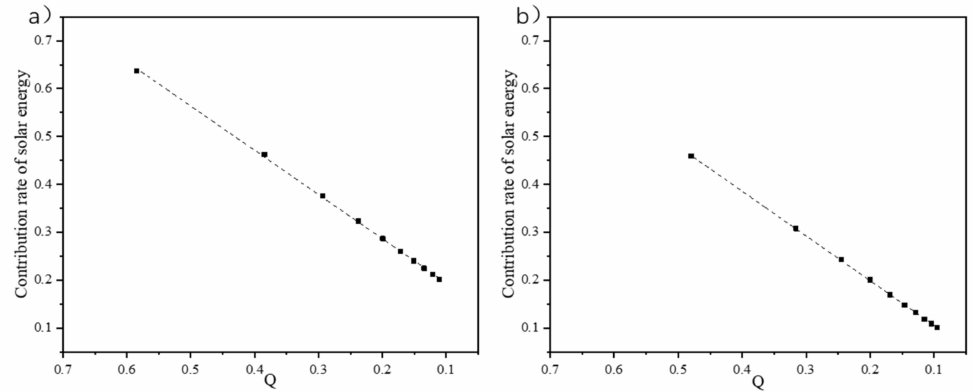
Figure 3. When Q is the independent variable, the analysis of solar guarantee rate of office building and three-star hotel is shown in graph ( a ) and graph ( b